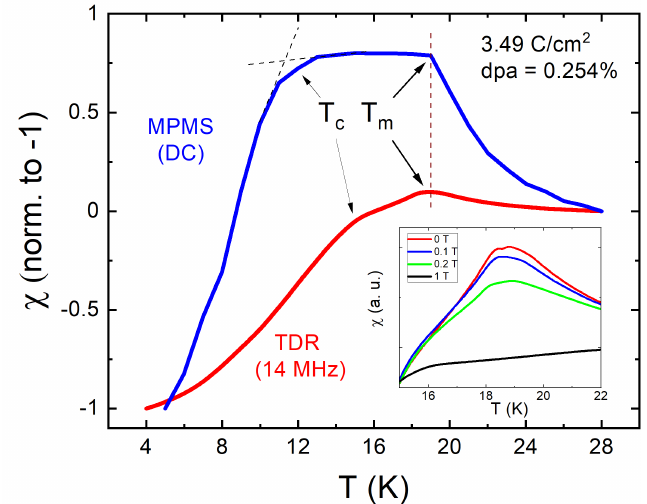
Figure 4. Magnetic susceptibility of EuFe 2 ( As 0.77 P 0.23 ) 2 single crystal after 2.5 MeV electron irradia- tion with a dose of 3.49 C/cm 2 (0.254 at.% dpa) measured in a DC regime using MPMS (top blue curve) and at 14 MHz using TDR (red curve). The inset shows the evolution of the TDR peak near the ferromagnetic transition for different applied magnetic